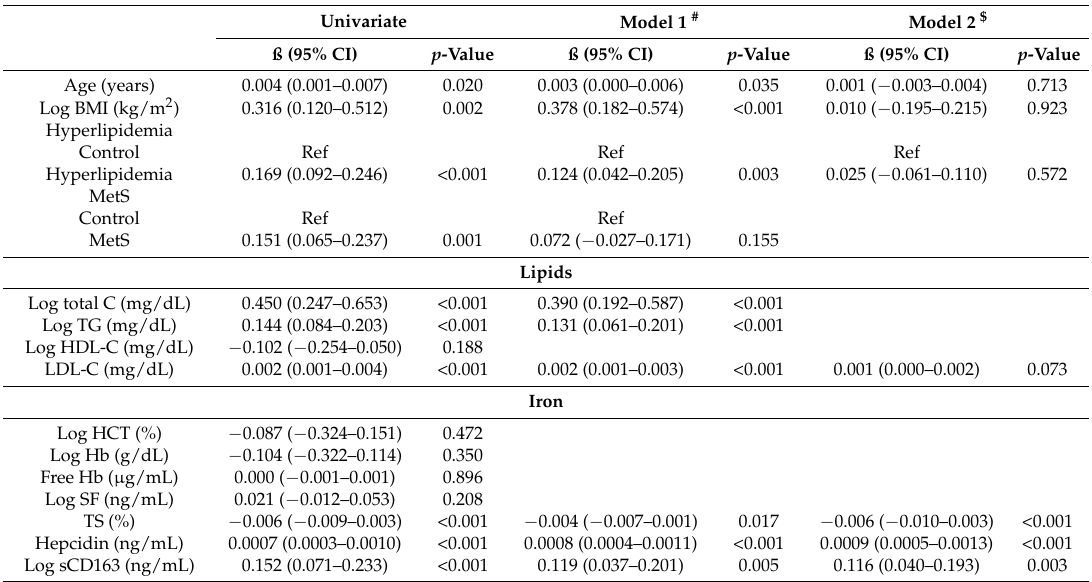
Table 2. Multivariate linear regression of correlations between log-transformed RBC aggregation and selected anthropometric, inflammation, lipid, glucose, and iron indicators.